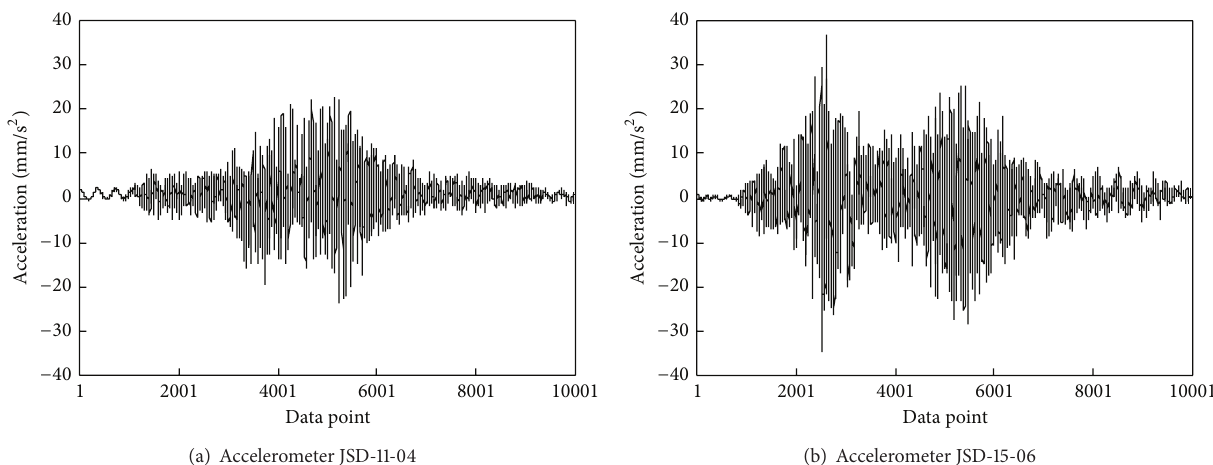
Figure 2: Transverse acceleration time histories of the main girder induced by a high-speed train.